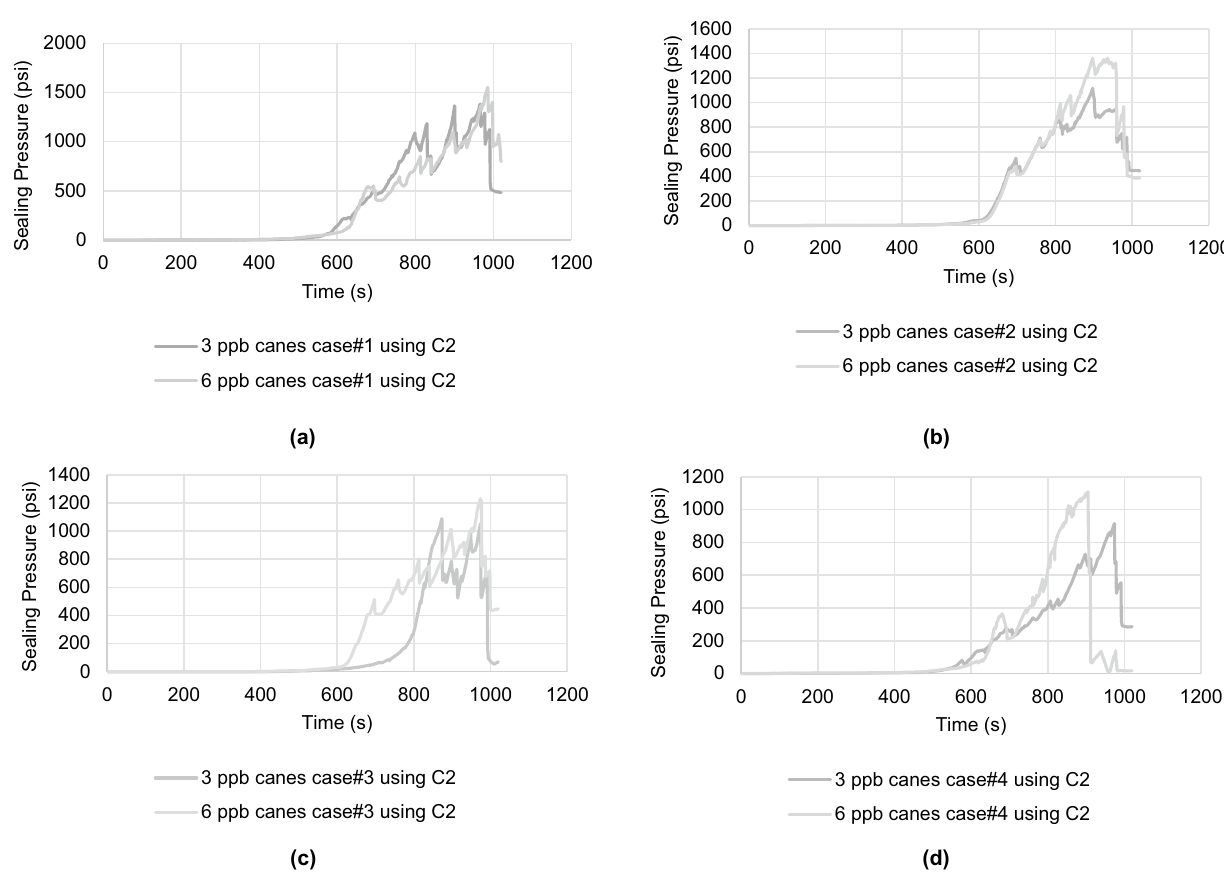
Fig. 18 HPA Pressure versus Time plot for Canes showing maximum sealing pressure at different concentrations, a case#1, b case#2, c